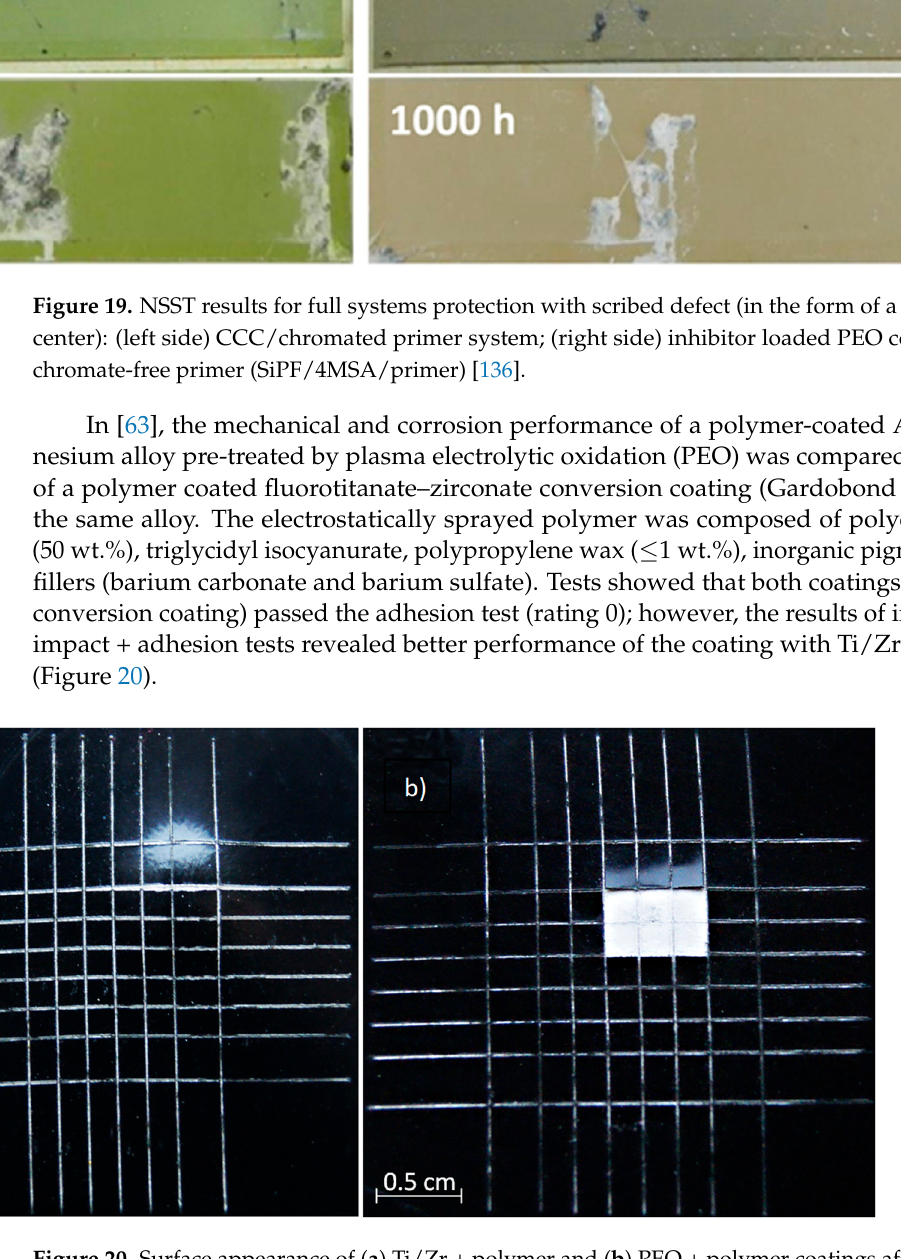
Figure 18. Salt spray testing results of Cr(VI)-based commercial coating and varied PEO covered with three-component epoxy primer, evaluated according to ASTM D 1654 standard [135].